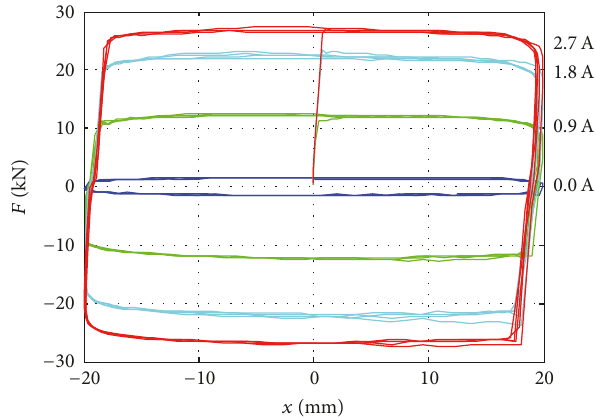
Figure 3: Cyclic force-displacement behaviour of the adopted prototype MR dampers